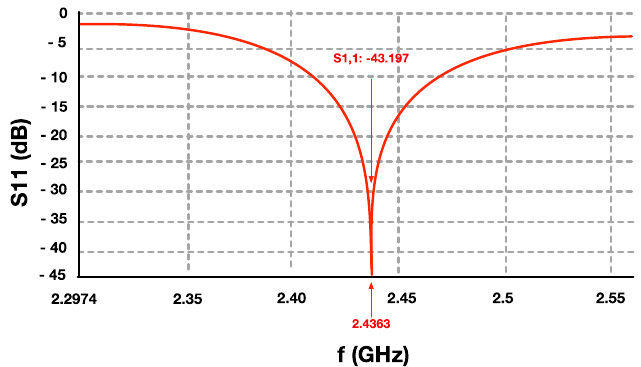
Figure 9. Radiation diagram and simulated 2 × 1 array gain.